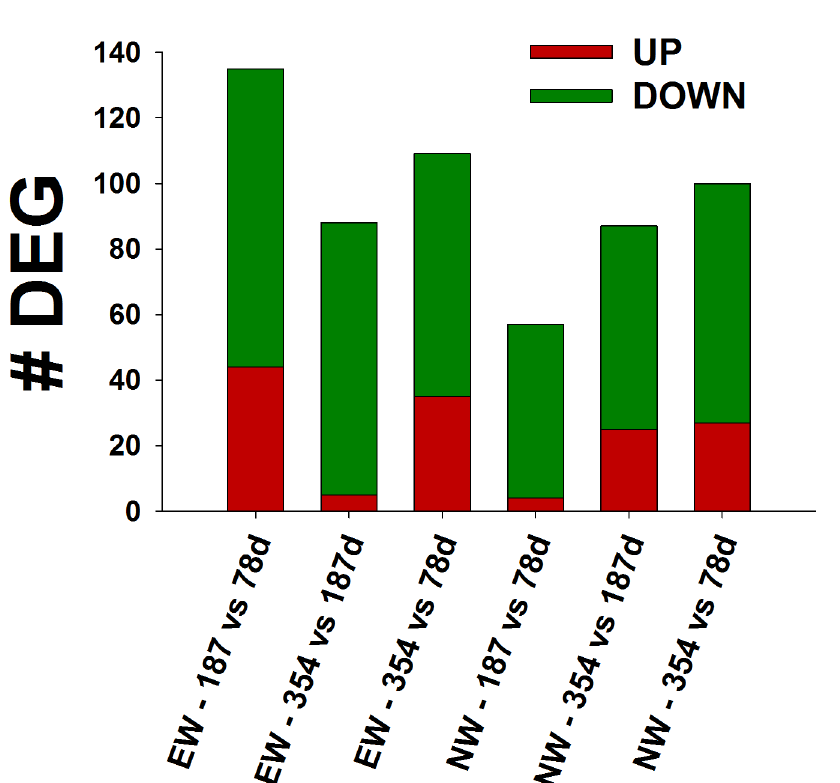
Fig 2. Differentially expressed genes (DEG; FDR < 0.10 and uncorrected P value < 0.05) in early wean (EW) and normal wean (NW) steers during the growing (78 to 187 days of age), finishing (187 to 354 days of age) and growing and finishing phases (78 to 354 days of age). Number of DEG for each comparison are those with overall FDR < 0.10, uncorrected P value < 0.05, and P < 0.05 between the specific time